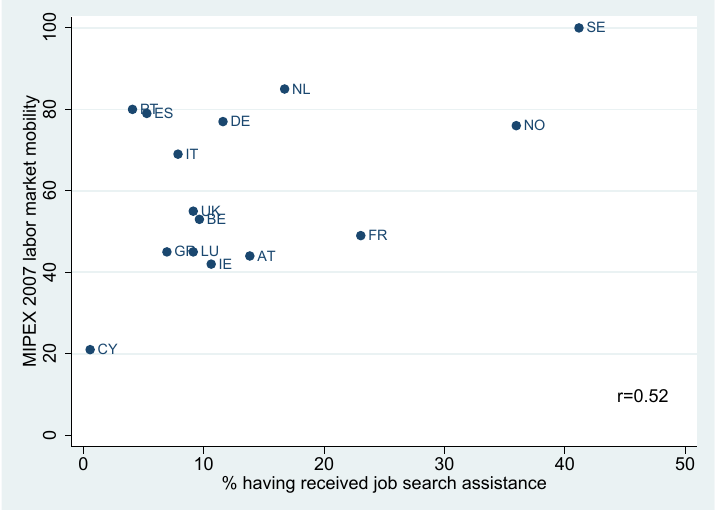
Figure 4: Proportion of immigrants who received labor market counseling and countries’ MIPEX of labor market